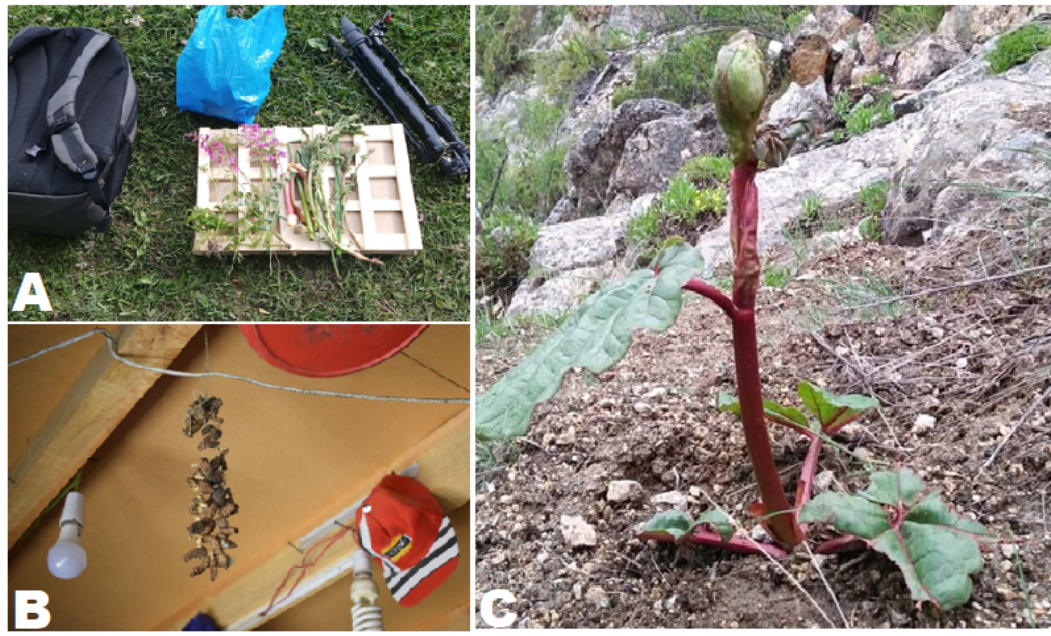
Figure 3. ( A ): A few flowering specimens collected for the herbarium; ( B ): Morchella esculenta hanging by a string at a local shop in Imit village and ( C ): Rheum sp.